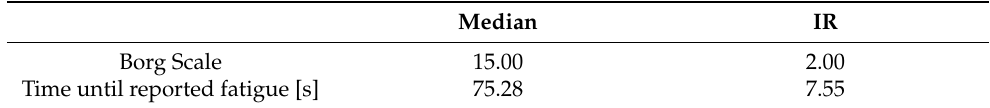
Table 1. Median and interquartile range (IR) values of the time until reported fatigue and the Borg scale of perceived